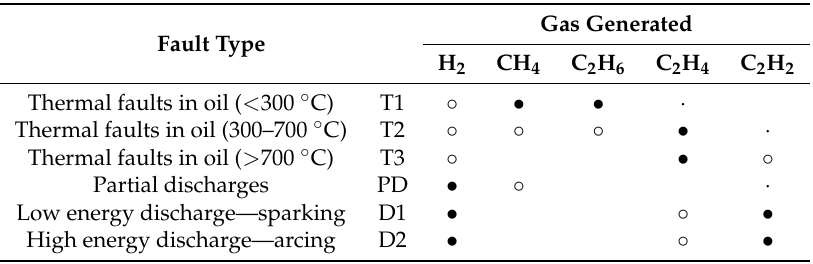
Table 1. Gas formation based on the type of failure [6,7].